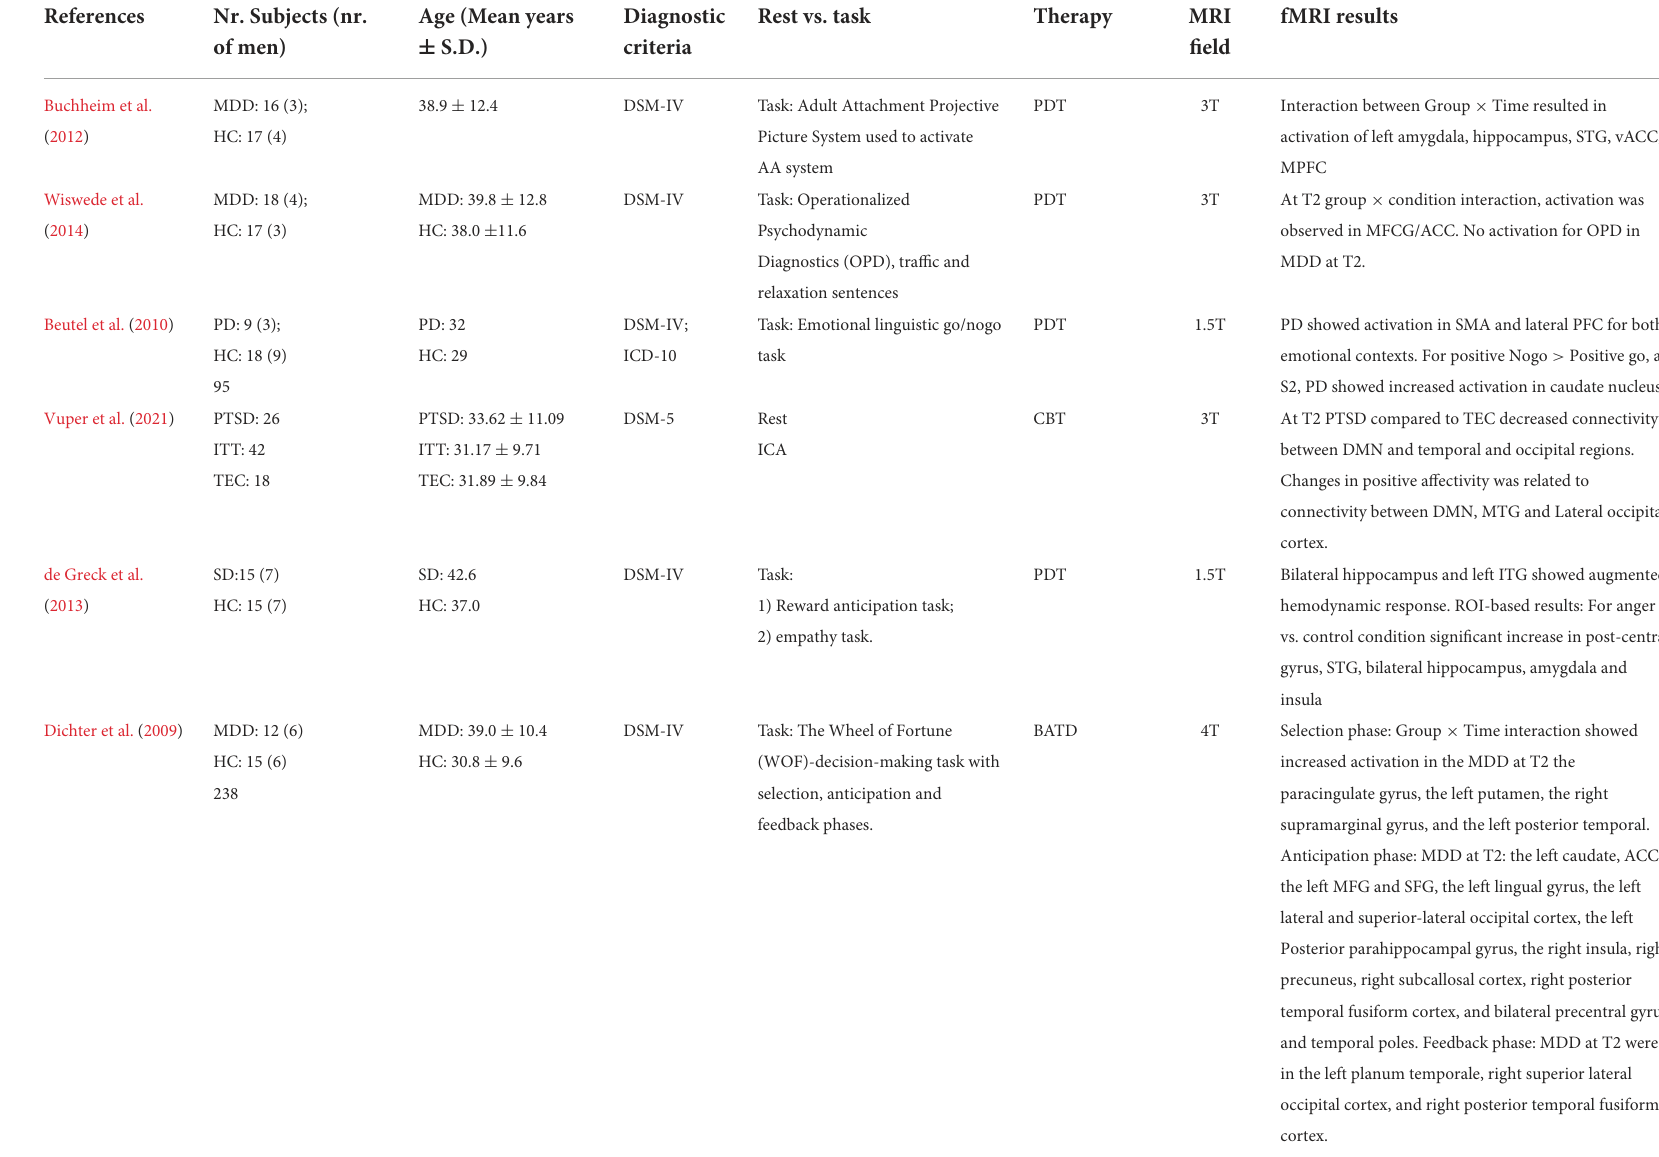
TABLE 1 Characteristics of the included